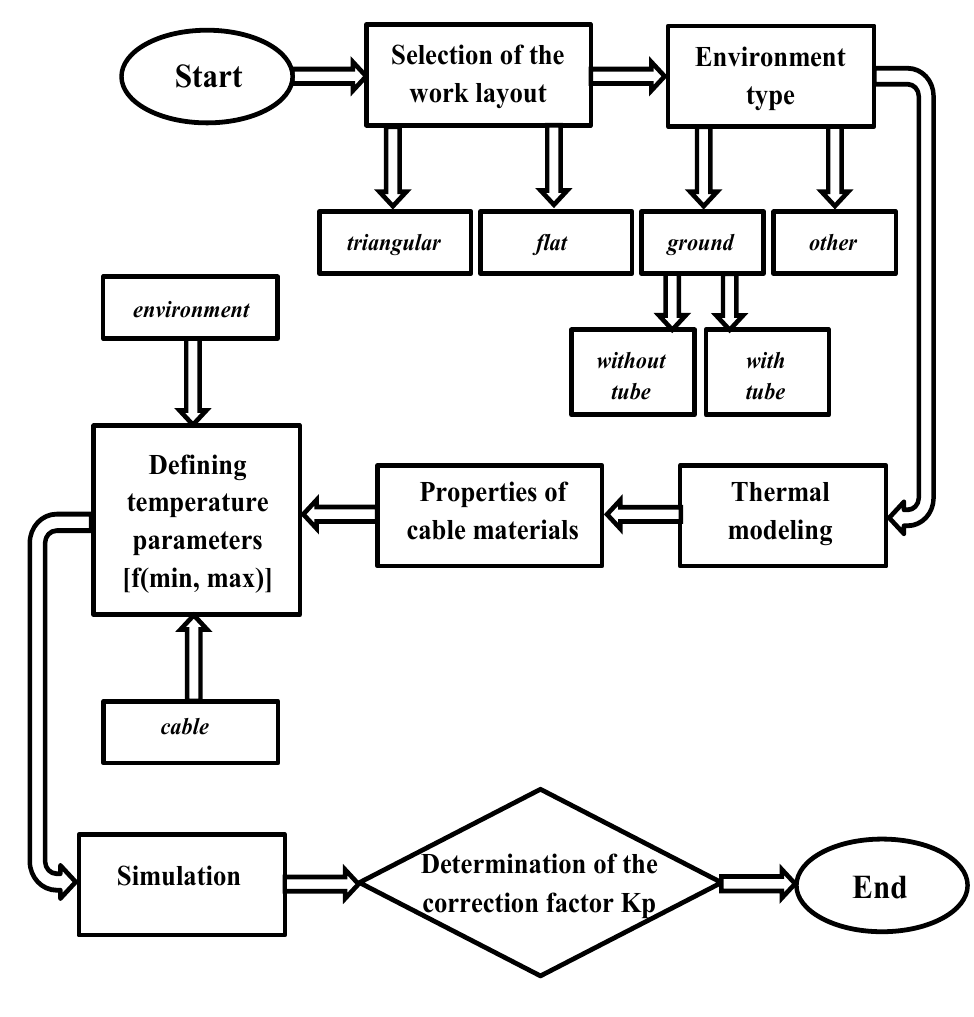
Figure 5. Block diagram of the proposed method of assessing the impact of changing the temperature of the external environment on the load capacity of the cable